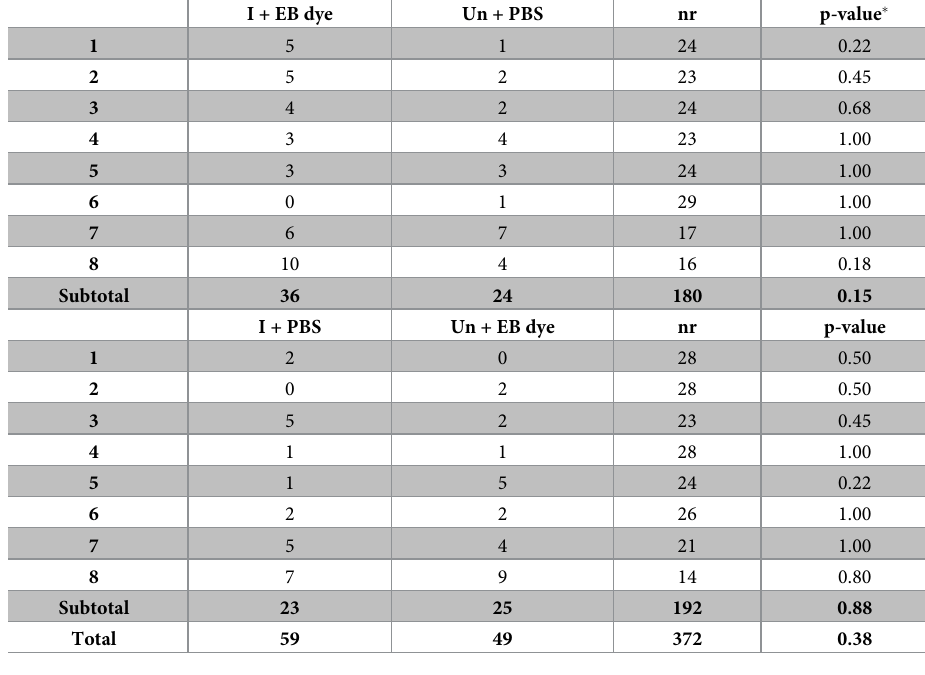
Table 1. Number of females that fed on each mouse in the different replicates. I + EB dye: infected mice injected with Evans Blue dye; Un + PBS: uninfected mice injected with PBS; I + PBS: infected mice injected with PBS; Un + EB dye: uninfected mice injected with Evans Blue dye; nr: no response. I + EB dye Un + PBS nr p-value � 1 0.22